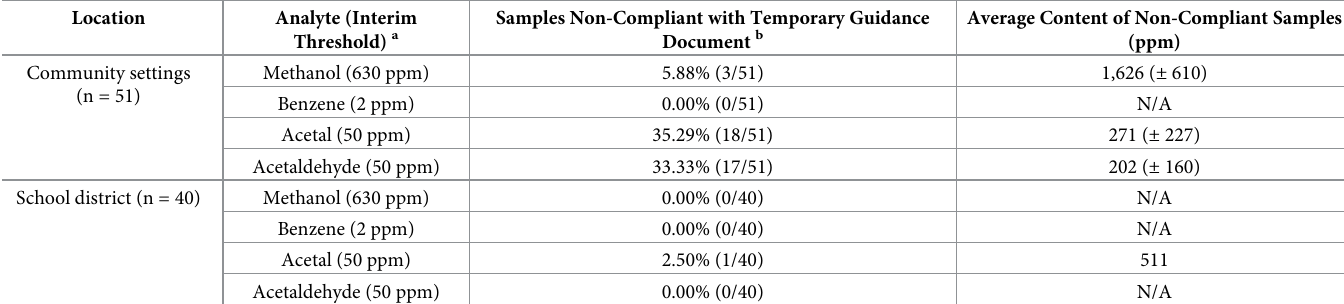
Table 2. Results of FDA impurity analysis of ABHS samples from bulk refillable